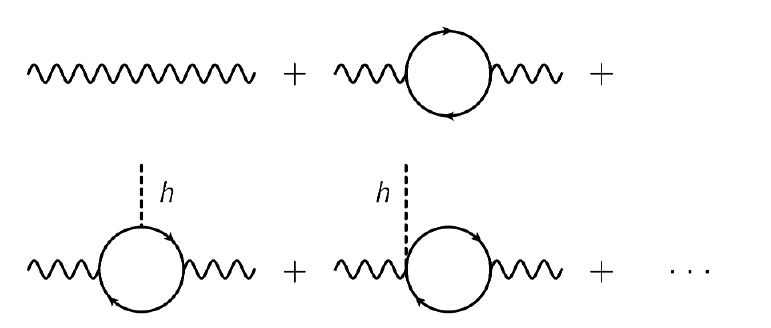
Figure 1 . The (cid:12)rst term in the top line represents the classical propagation of the photon whereas the second term in the top line represents the one-loop correction to the propagator due to vacuum polarization in (cid:13)at space. All diagrams in the bottom line represent vacuum polarization in the presence of a curved metric g (cid:22)(cid:23) = (cid:17) (cid:22)(cid:23) + h (cid:22)(cid:23) treating h (cid:22)(cid:23) as a perturbation. The Barvinsky- Vilkovisky expansion gives the covariantized nonlocal action resumming the speci(cid:12)c powers of h required for general covariance. Equation (2.11) obtained by integrating the anomaly resums these diagrams to all orders into a simple expression for Weyl-(cid:13)at